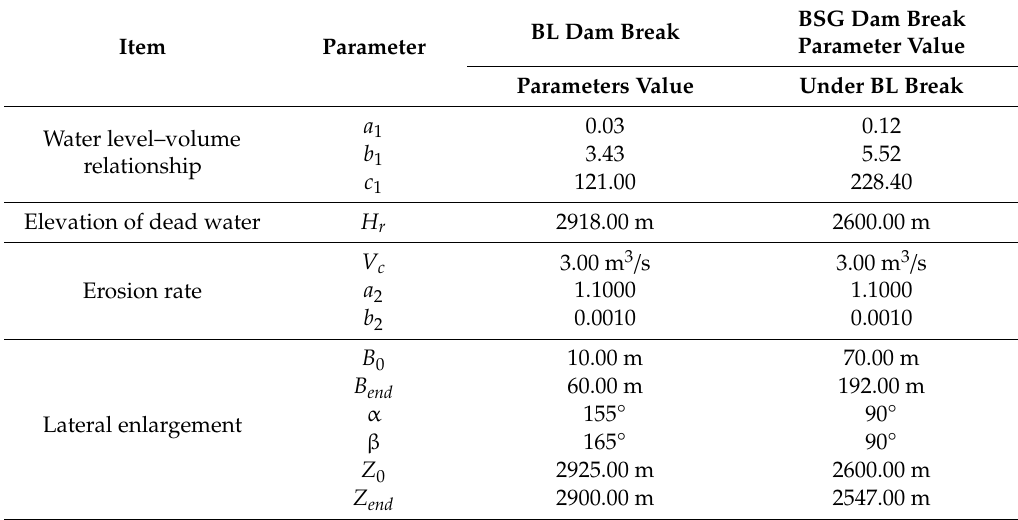
Figure 10. The BSG regulation progress.